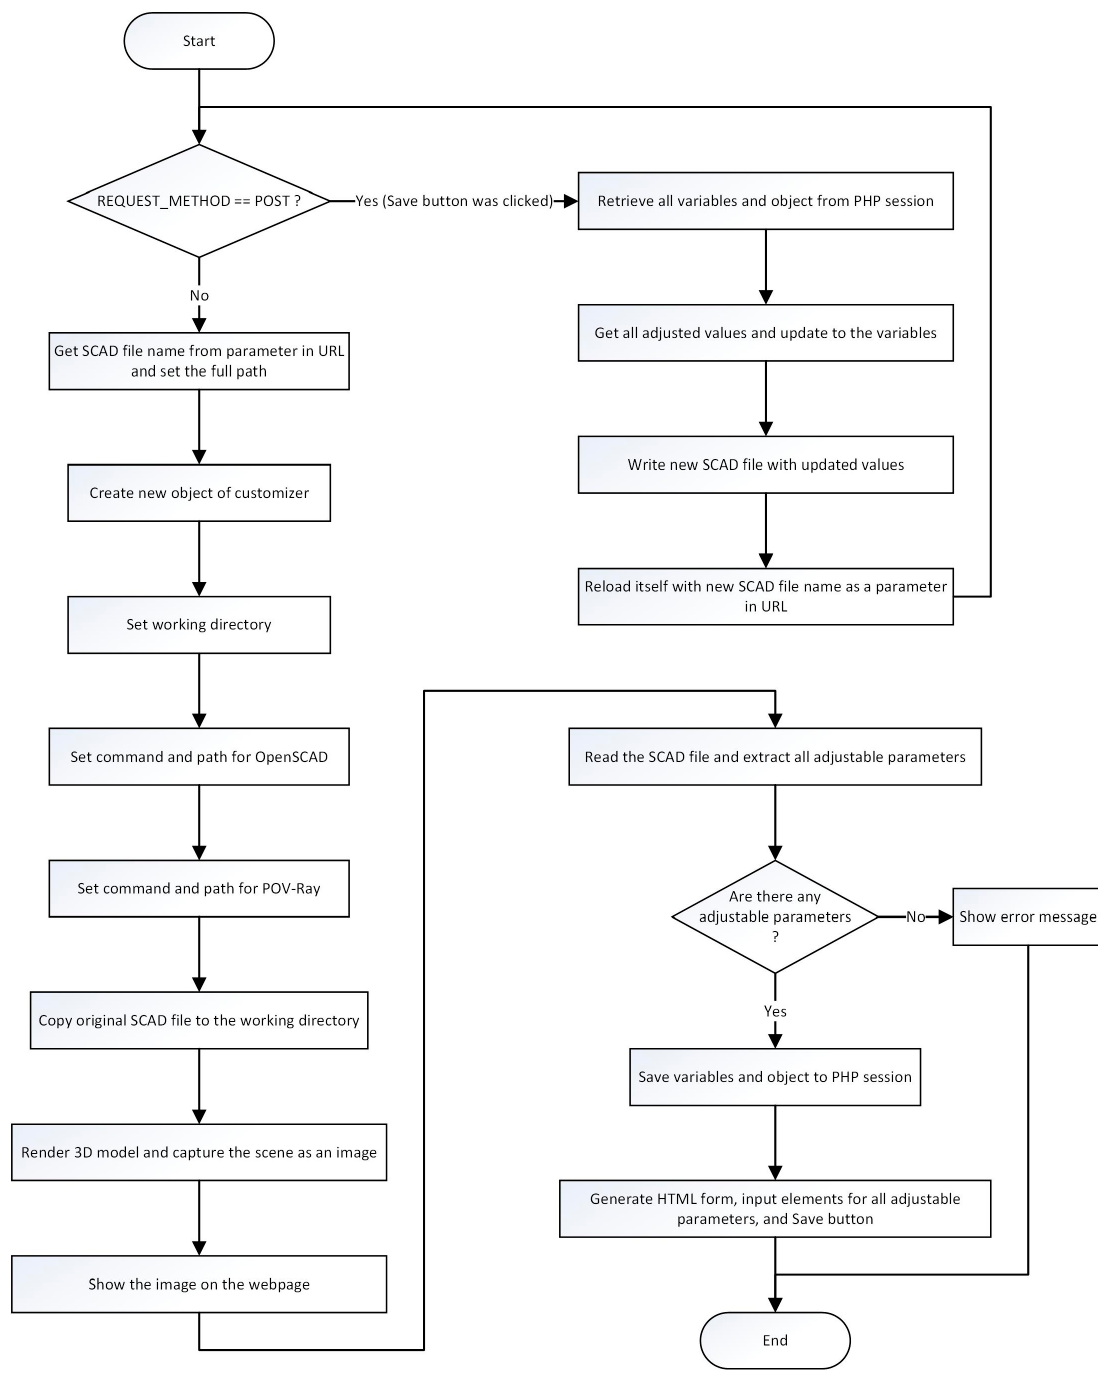
Figure 1. The flowchart of the use of the Free Open Source 3-D Customizer.